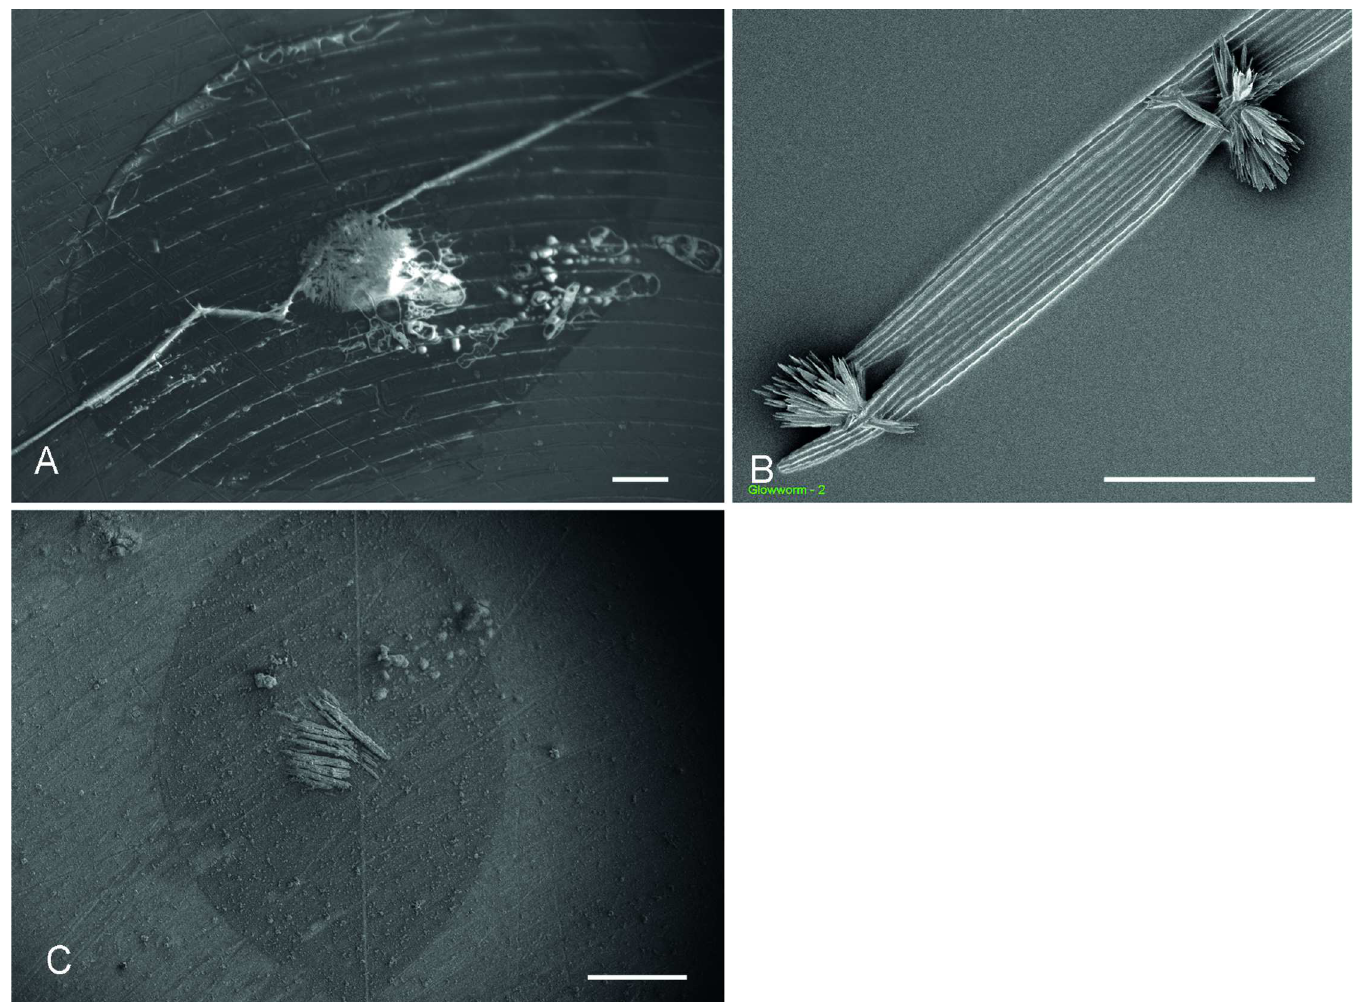
Fig 6. When maintained at 30% humidity, A) the water droplet contour (blue plus), as well as the core (red hashtag)of the adhesivethread remain visible. Attachment of the core to the thread takes place in the central part of the droplet (yellowasterisk), the core is constricted and enclosesthe thread in this area. B) In the dried state, the core (red hashtag)of the final droplet mostly appearsas a web-likeballooning structure and is C) opticallyactive in the polarizedmicroscope. Also, the core of the normal thread droplet appearscrystallinein the dried state, being D) opticallyactive in the polarizedmicroscope E) and reflective in the light microscope. Under highlyhumid conditions (100%), a re-hydration(blue plus) of the core (red hashtag) for the F) normal droplet as well as the G) final droplet takes place. H) In the polarized microscopethe re-hydratedpart of the core (blue plus) is opticallyinactive in relationto the dried area (red